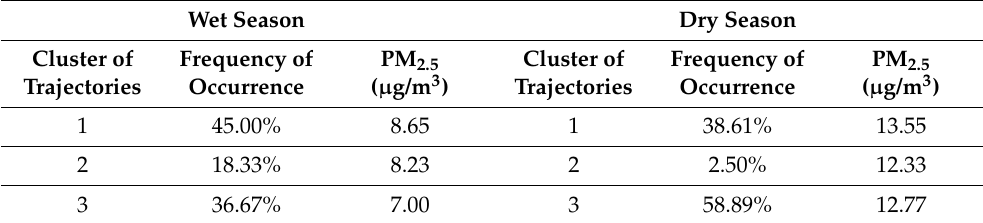
Table 3. The level of the PM concentrations at the air parcel arrival ( µ g/m 3